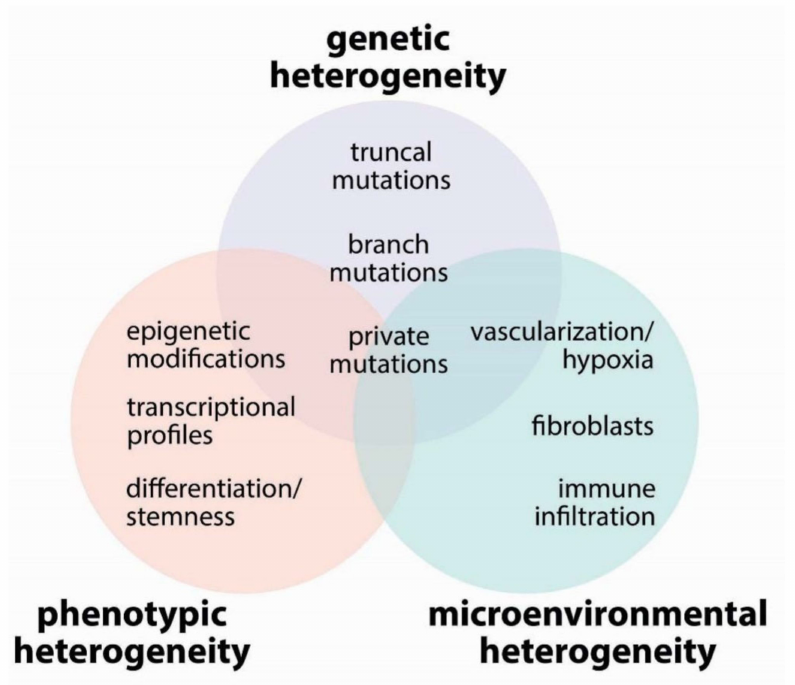
Figure 2. Major determinants of tumor